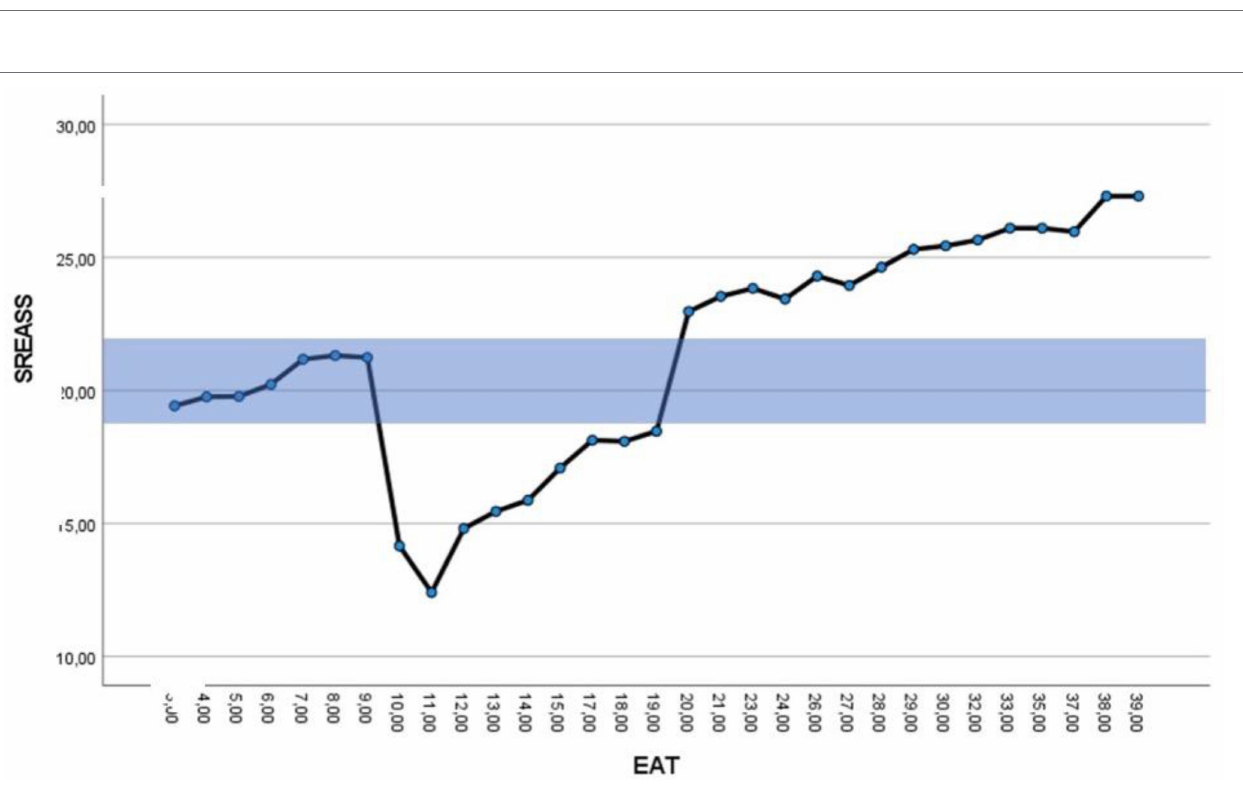
FIGURE 1 | Curvilinear relations between self-regulation of eating attitudes and disordered eating.